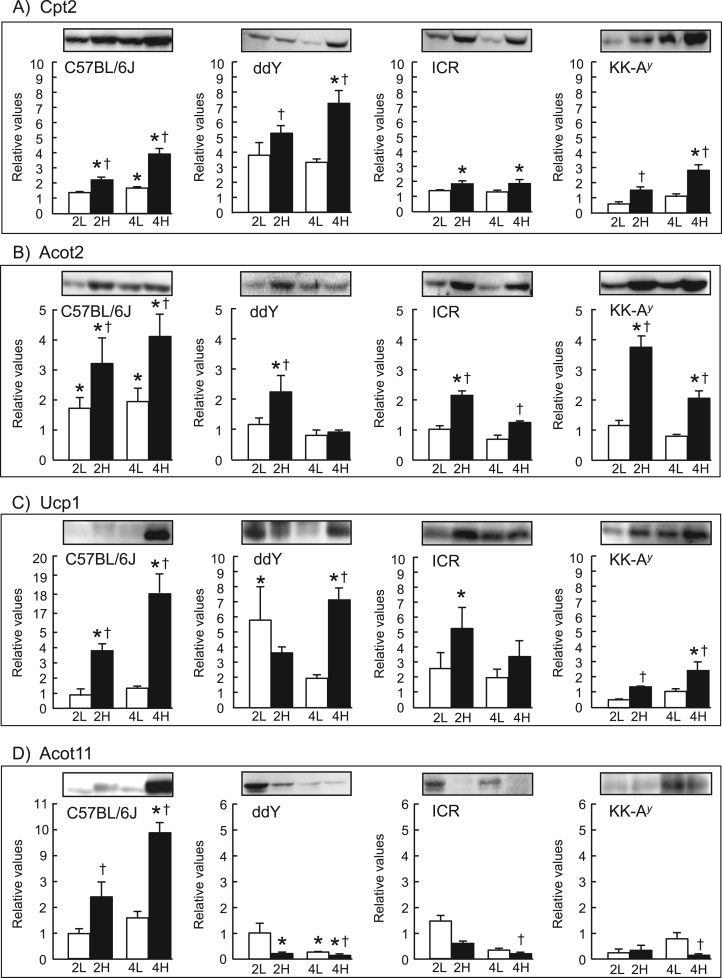
Changes in expression levels of Cpt2 (A), Acot2 (B), Ucp1 (C) and Acot11 (D) in BAT of mice after short-term HFD-feeding. After 1 week of acclimatization (baseline), different strains of mice (C57BL/6J, ddY, ICR and KK-Ay) were fed a LFD for 2 (2 L) or 4 weeks (4 L), or a HFD for 2 (2 H) or 4 weeks (4 H), and the expression levels of the proteins (A–D) were analyzed by western blotting with BAT homogenates. Signal intensities of the protein bands (per mg protein) were measured and are expressed relative to the baseline values, which were set as 1 (mean±SEM of 3–7 mice). *p<0.05 vs. baseline; †p<0.05 vs. the LFD group at the same feeding time period. Representative western blots (20 µg protein/lane) for Cpt2 (65 kDa), Acot2 (45 kDa), Ucp1 (30 kDa) and Acot11 (65 kDa) are shown.